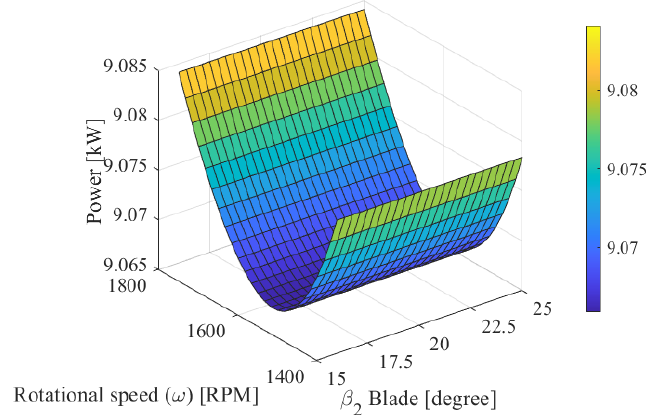
9 of 24 Figure 3. Variation of pump efficiency with rotational speed and hub inlet draft angle. 4. 3-D Computational Model 4.1. Governing Equations On the other hand, Figure 4 shows a graph between shaft power, the blade angle beta, and the impeller’s rotational speed. It could also be depicted from Figure 4 that the